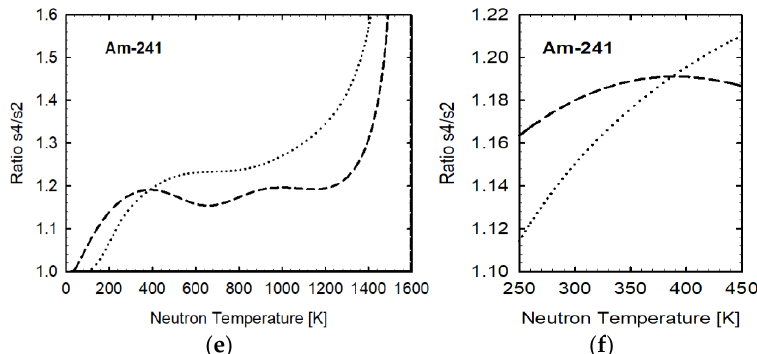
Figure 6. ( a ) s-factors, s 2𝑊 (solid line), s 4𝑊 (dotted line), s 4𝐻 (dashed line) for 241 Am as a function of neutron temperature 𝑇 𝑛 , for sample temperatures 𝑇 𝑠 = 300 K (black) and 1000 K (red); ( b ) Expanded figure of ( a ); ( c ) Ratios of s 2𝑊 (solid line), s 4𝑊 (dotted line), s 4𝐻 (dashed line) between 𝑇 𝑠 = 300 K and 1000 K; ( d ) Expanded figure of ( c ); ( e ) Ratios of s-factors, s 4𝑊 /s 2𝑊 (dotted line) and s 4𝐻 /s 2𝑊 (dashed line) for 𝑇 𝑠 = 300 K; ( f ) Expanded figure of ( e ).